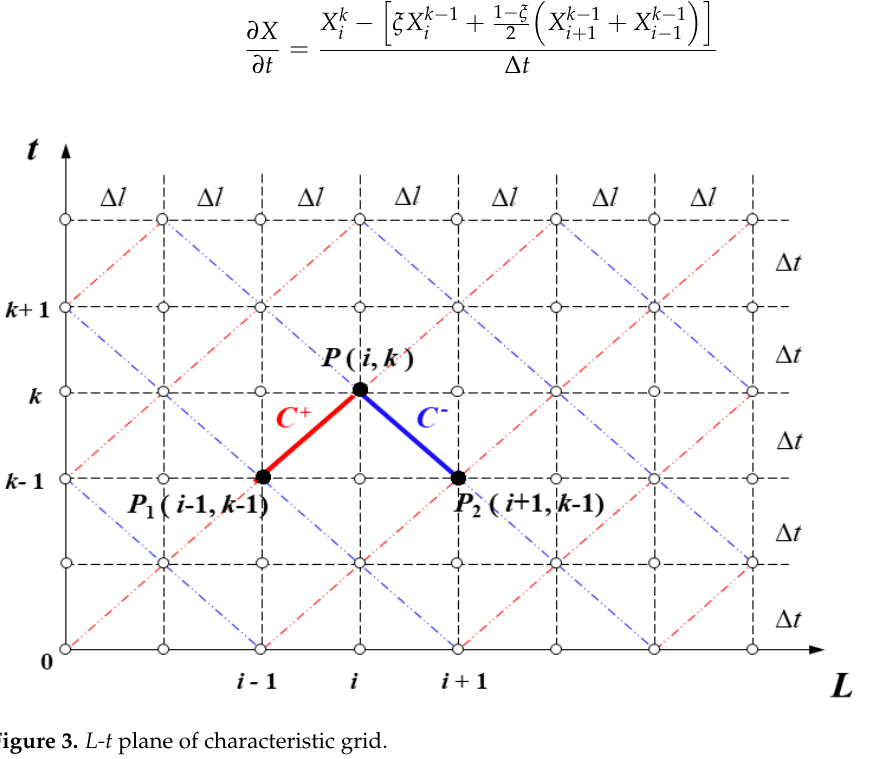
Figure 3. L-t plane of characteristic grid.